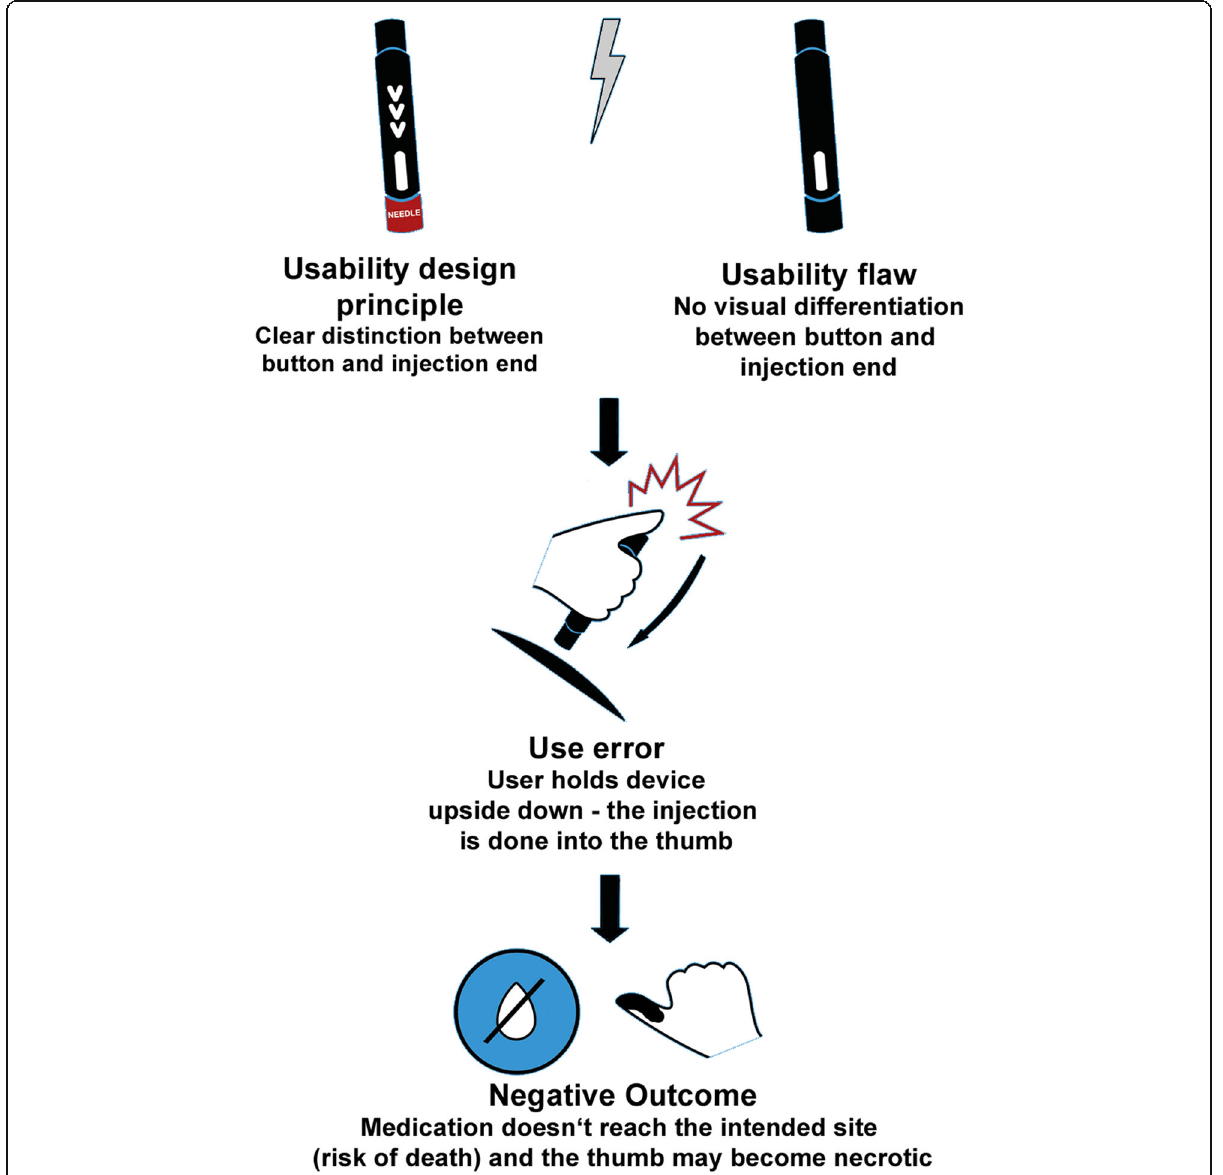
Fig. 1 Schematic representation of the causal-and-effect chain between the violation of a usability design principle, the usability flaw, the use error, and the negative